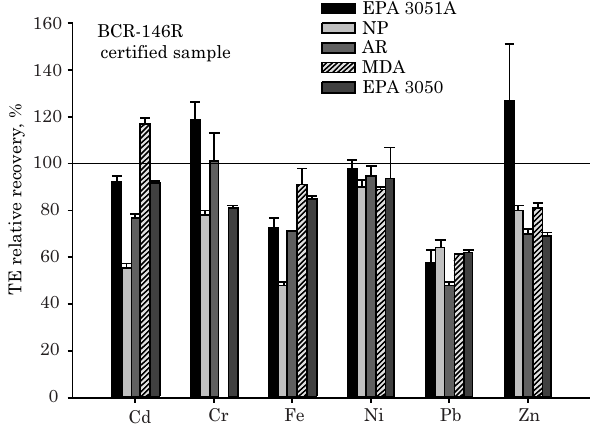
Figure 1. Relative recovery (100 % value corresponds to the level of the corresponding TE in the certified sample) of trace elements (TEs) in the certified industrial sewage sludge (BCR 146-R) through the use of the different digestion methods. NP: nitric-perchloric, AR: aqua regia , MDA: modified dry